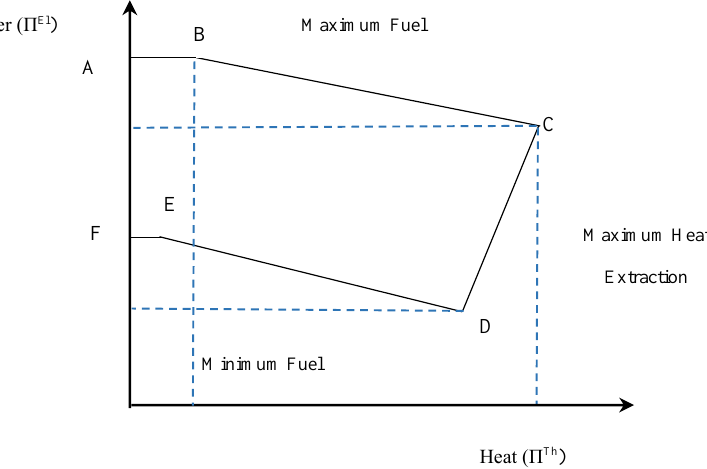
Figure 3. Heat-power feasible operation range (FOR) of the combined heat and power (CHP) [24].